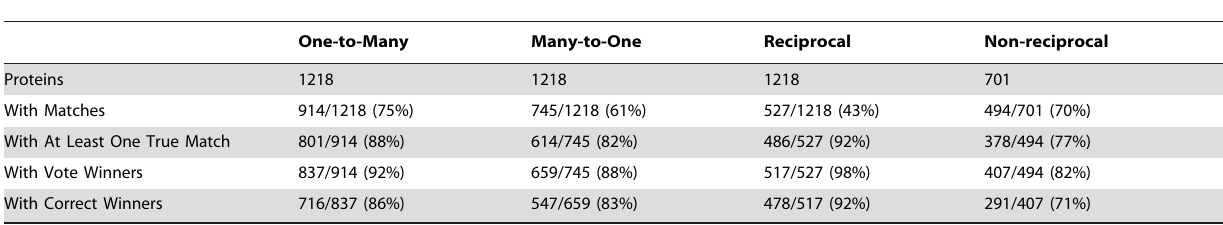
Table 6. ETA Annotation of Structural Genomics Annotated Set.